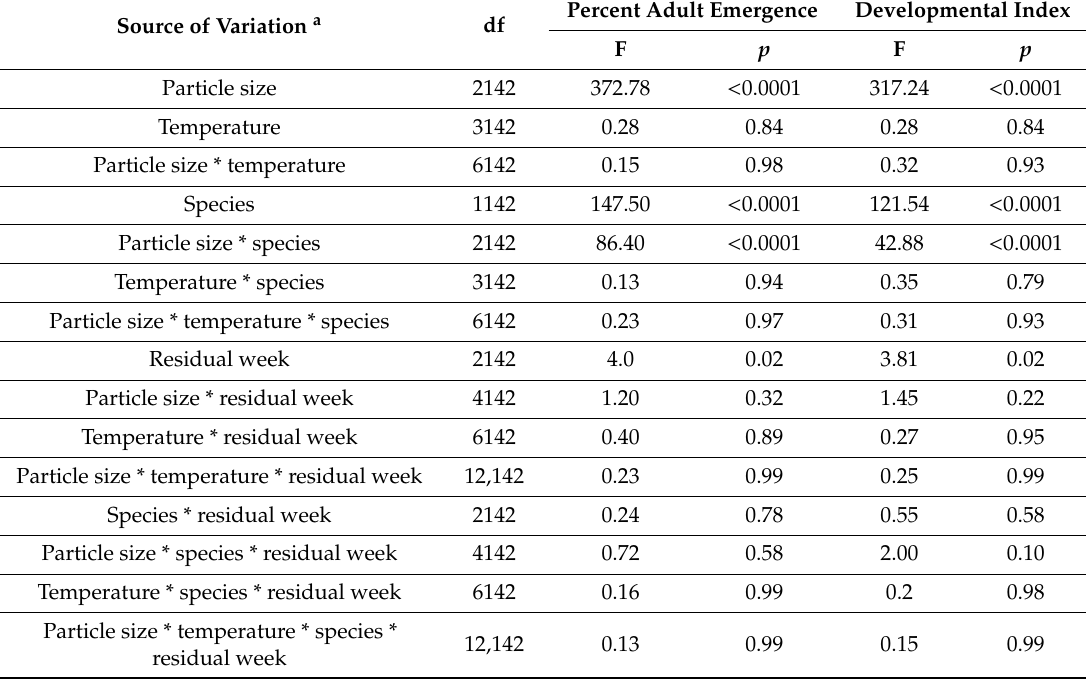
Table 1. Analyses of variance of percent adult emergence and developmental index of dermestids in concrete arenas after late larvae were released in arenas at 1, 3 and 6 weeks following the application of aerosol at di ff erent particle sizes and storage of arenas at di ff erent temperature treatments of 25, 30, 35, and 40 ◦ C.